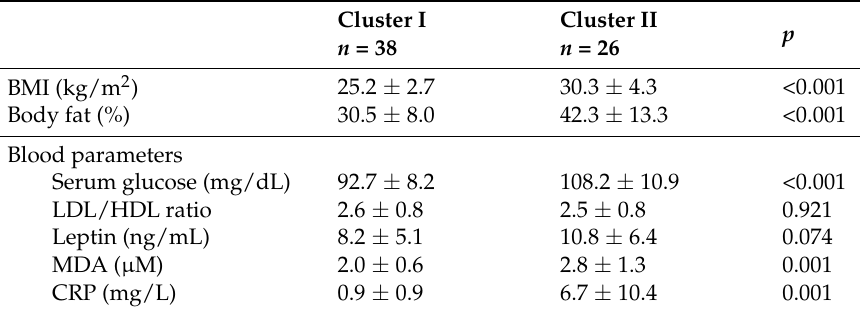
Table 4. Differences in the parameters used for cluster analyses.